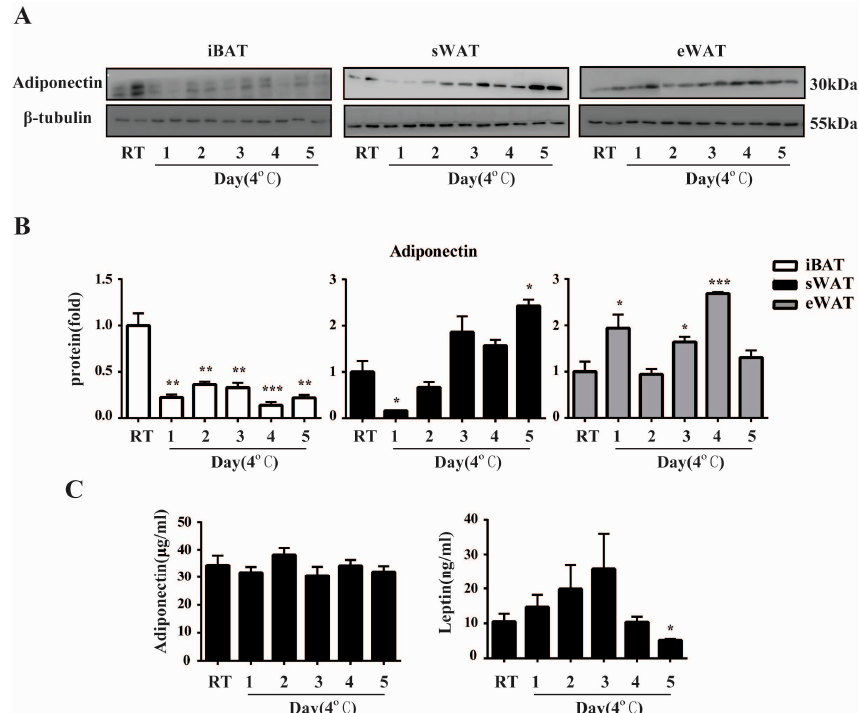
Figure 3. Cold exposure changes Adiponectin and Leptin protein levels in adipose tissues in mice. ( A ) Western blot analysis for Adiponectin using total protein isolated from iBAT, sWAT and eWAT of RT and Cold mice. ( n = 6 for each group); ( B ) Quantification of Western blot analysis. Protein content is expressed relative to the control and represents three independent experiments with triplicate observations in each experiment. Volume is the sum of all pixel intensities within a band. All data are normalized to β -tubulin and are expressed as mean ± S.E.M. (* p < 0.05, ** p < 0.01, *** p < 0.001); ( C ) Plasma Adiponectin and Leptin levels in RT and Cold mice were determined by ELISA. ( n = 6 per group) All data are presented as mean ± S.E.M. * p < 0.05, ** p < 0.01 for the Cold compared to the RT group.